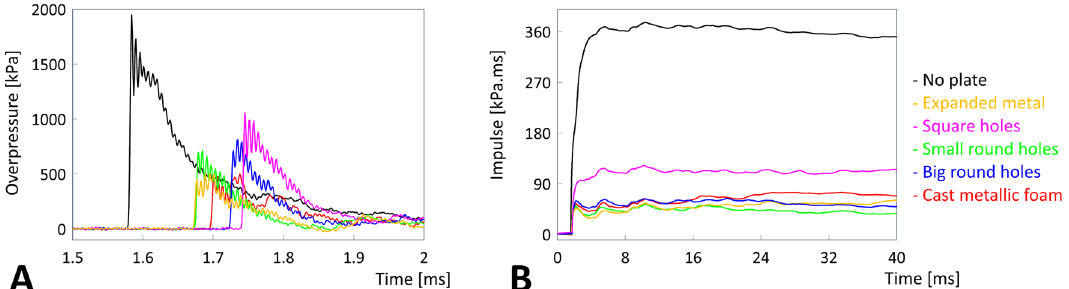
Fig. 11 Reflected overpressure ( A ) and impulse ( B ) measured on the wall positioned 50 mm behind the two plates for all types of